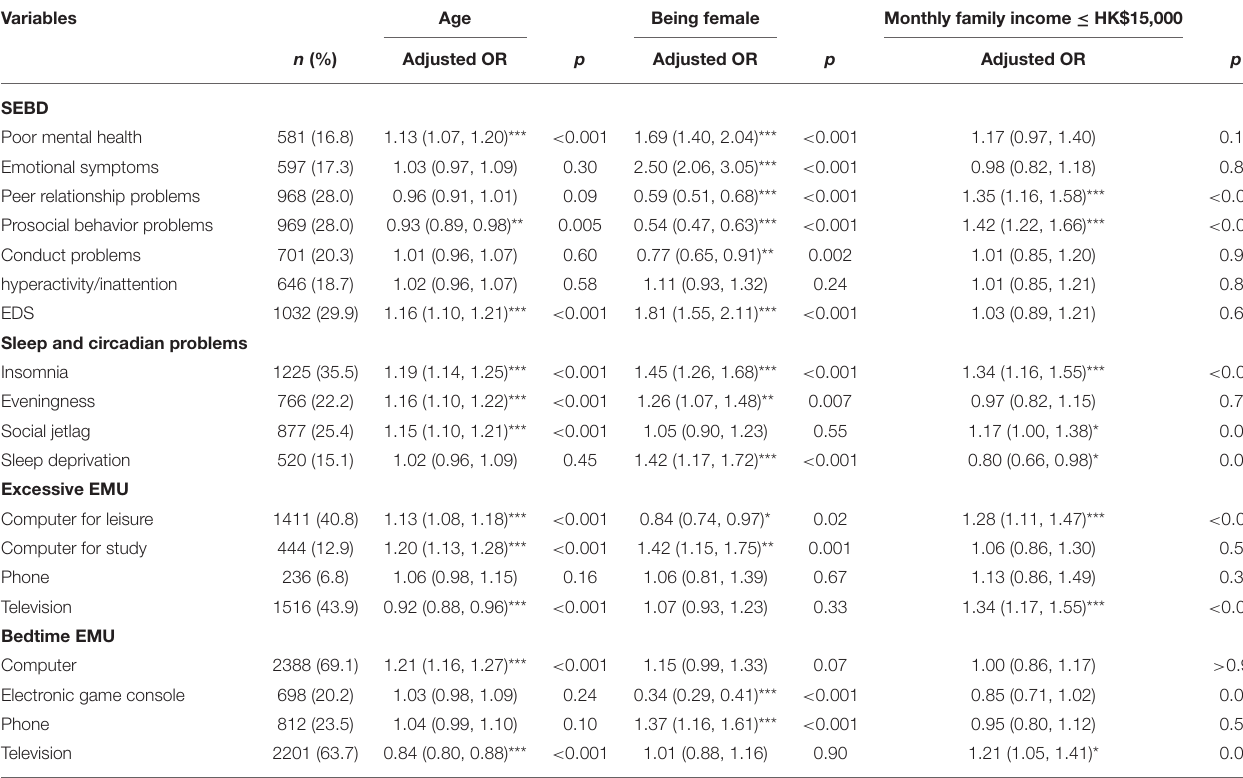
TABLE 1 | Associations between the studied variables and demographics (including age, gender, and family income).